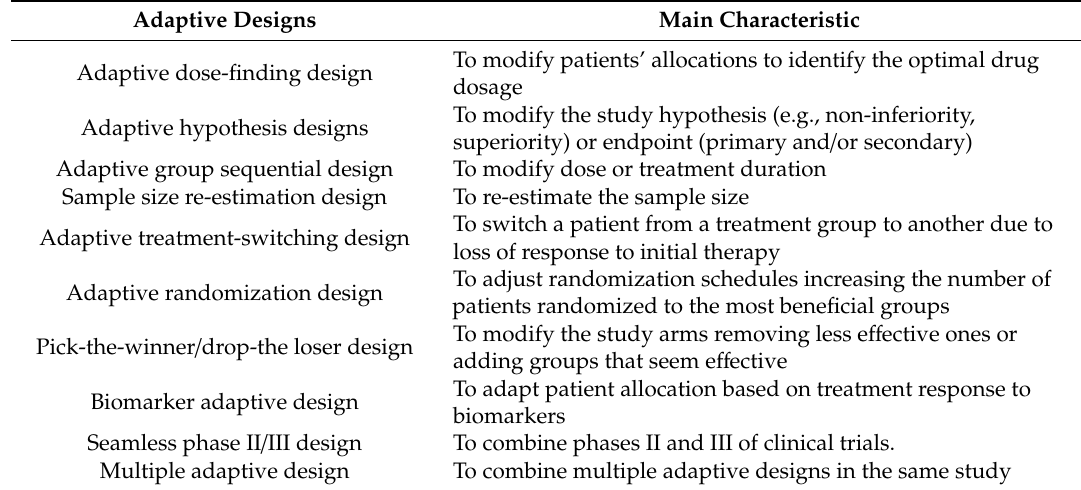
Table 1. Characteristics of adaptive